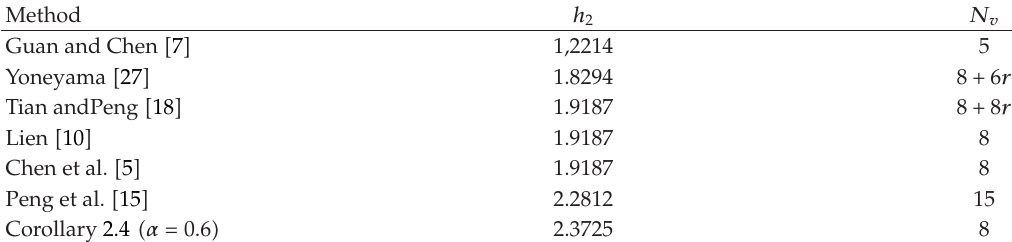
Table 4: MADB h h d (cid:2) h (cid:8) 0 (cid:3) in Example 3.6 for di ff erent methods (cid:2) Number of variables: 2 for unknown 1 N v ; Number of fuzzy rules: r (cid:3)